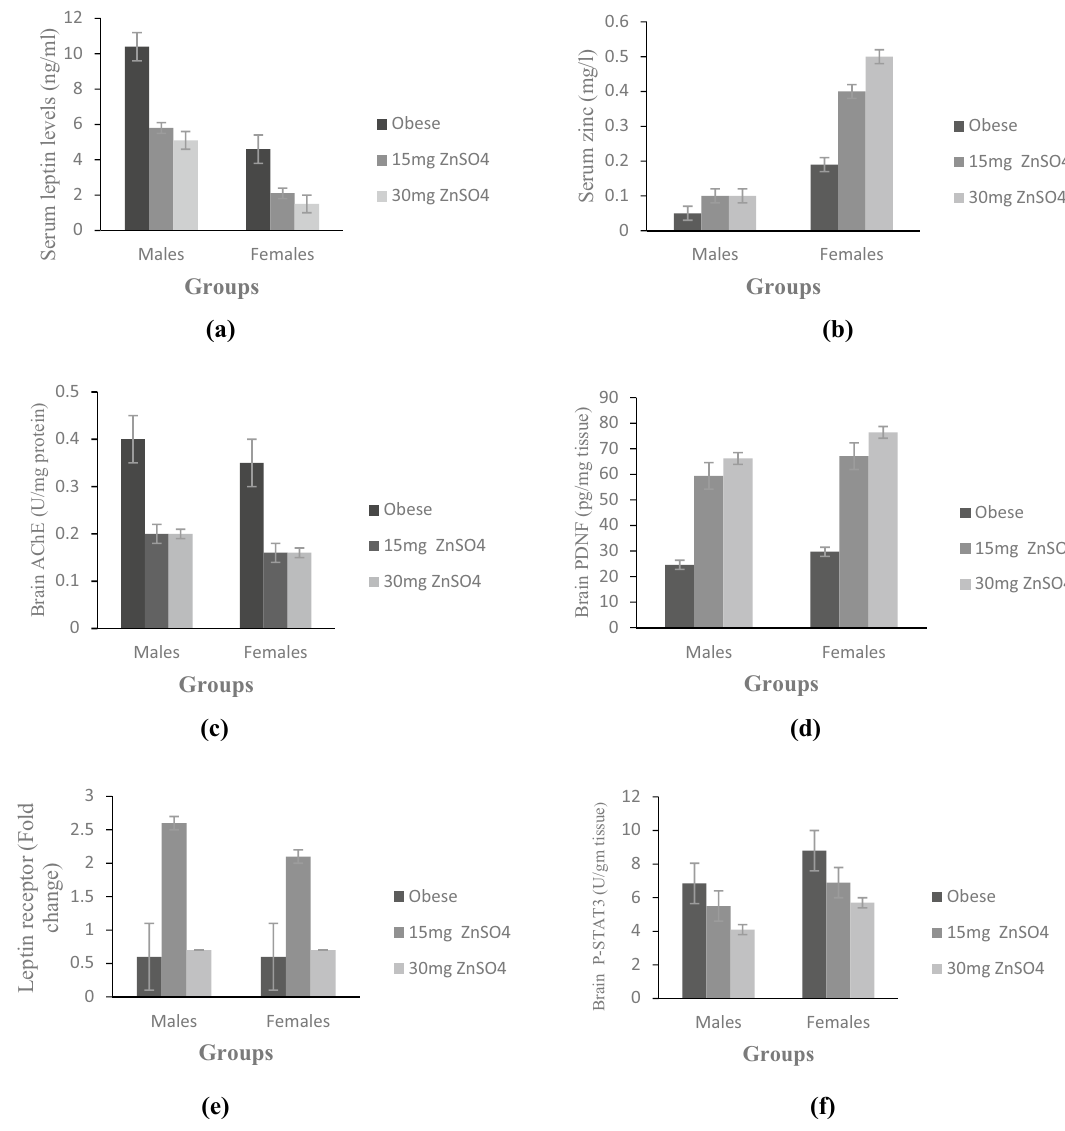
Figure 4. Comparison between male versus female obese rats before and after 15 mg ZnSO 4 , and 30 mg ZnSO 4 regarding; ( a ) serum leptin levels; ( b ) serum zinc content; ( c ) brain AChE (U/mg protein); ( d ) brain PDNF (pg/ mg tissue); ( e ) fold change in leptin receptor gene expression in brain tissues; ( f ) brain p-STAT3 (U/mg tissue). Results are expressed as (mean ±